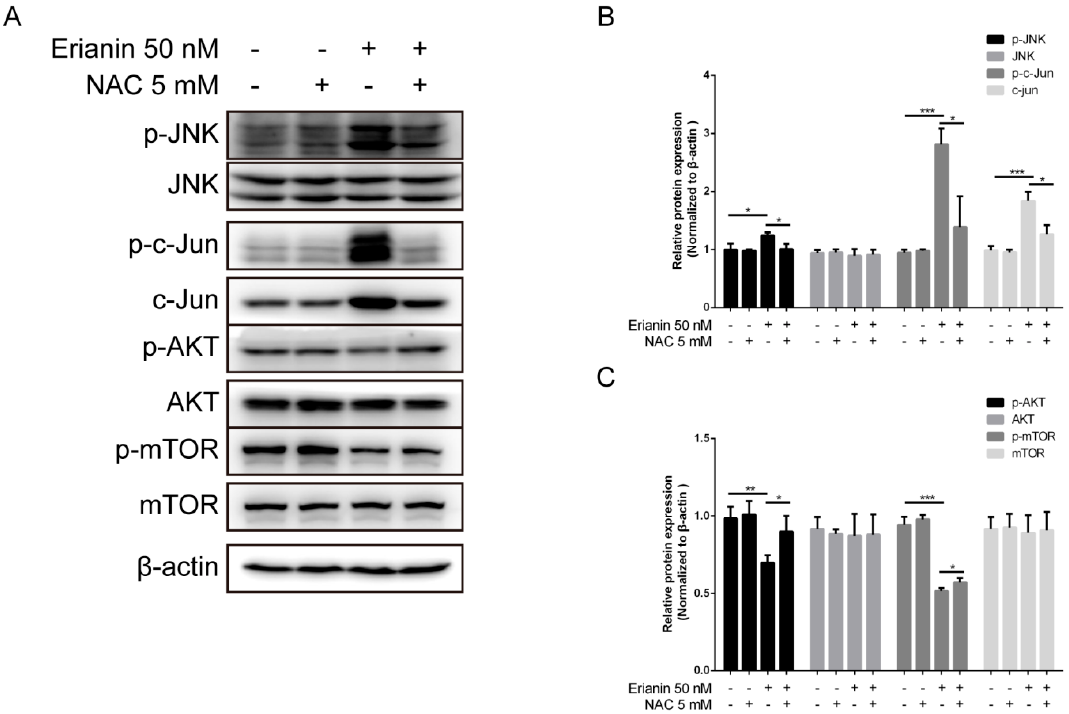
Figure 5. Erianin-activated JNK / c-Jun signaling pathway and erianin-inactivated AKT / mTOR signaling pathway through ROS regulation. Cells were pretreated with 5 mM of N -acetyl-cysteine (NAC) for 2 h and then incubated with 50 nM of erianin for 24 h. ( A ) Western blotting for the JNK / c-Jun and AKT / mTOR signaling pathways. ( B ), ( C ) The relative expression intensity of each protein was normalized to the internal control β -actin. The values are expressed as mean ± SD ( n = 3). * p < 0.05, ** p < 0.01, *** p < 0.005, significantly di ff erent compared with the untreated group and the NAC-treated group.